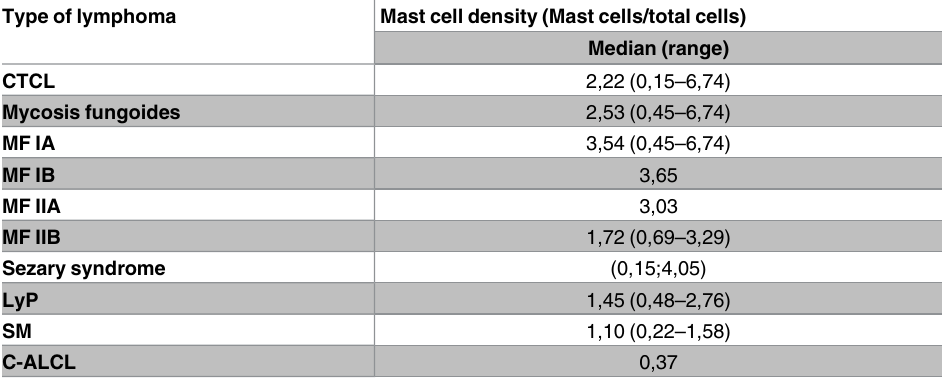
CTCL = primary cutaneous T-cell lymphomas; MF = Mycosis fungoides; LyP = lymphomatoid papulosis; SM = primary cutaneous CD4 + small/medium sized pleomorphic T-cell lymphoma C-ALCL = primary cutaneous anaplastic large cell lymphoma;